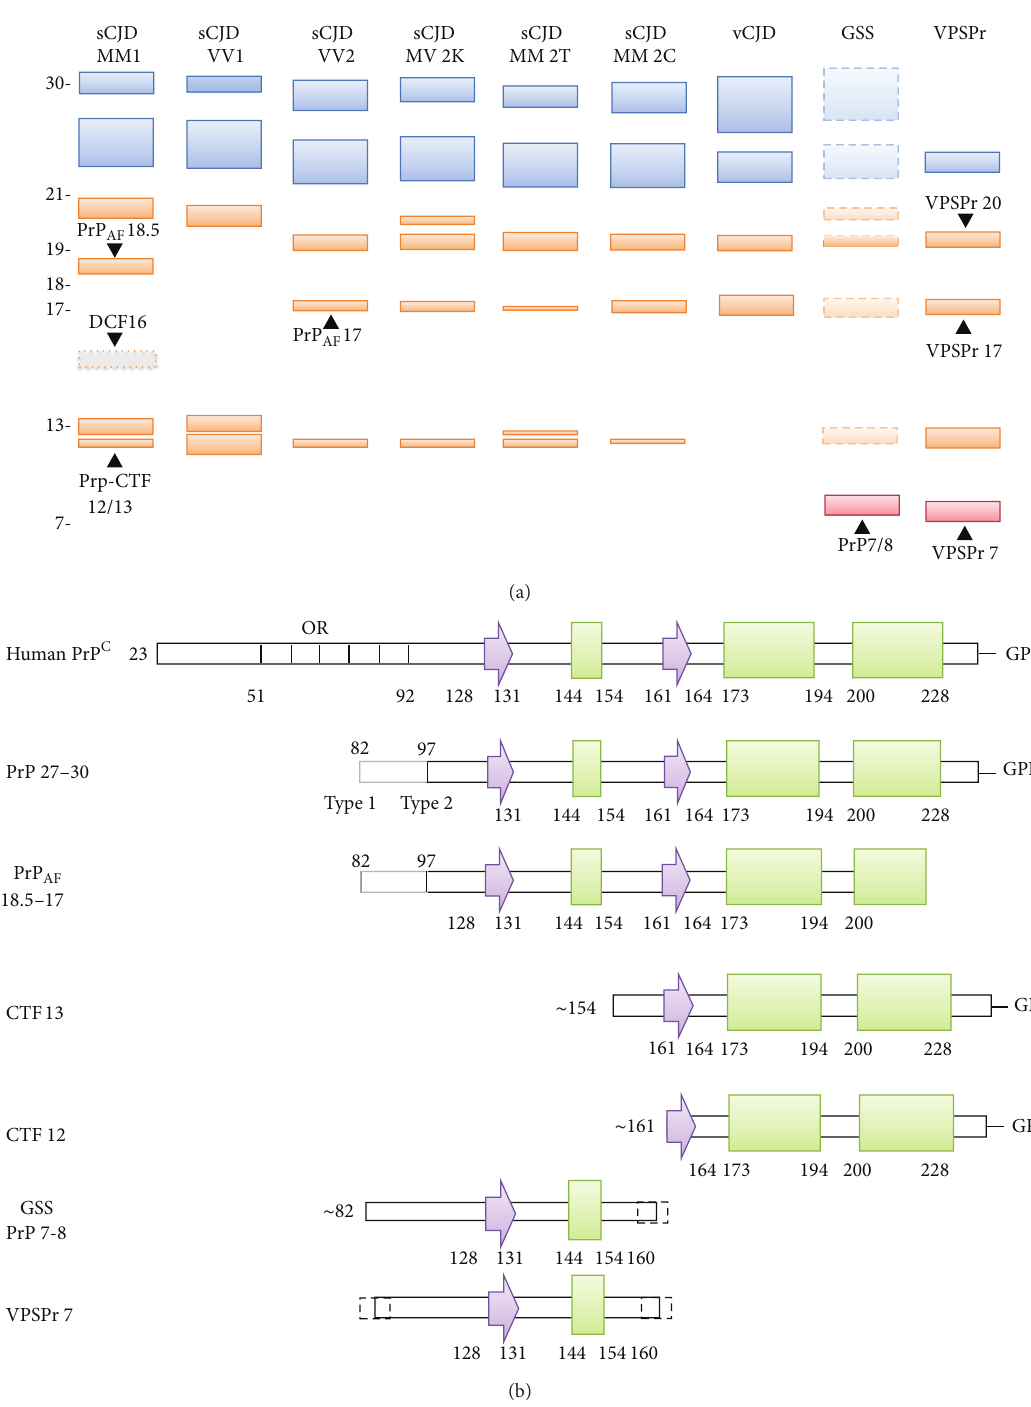
Figure1:(a)SchematicrepresentationofthespectrumofPrP res fragmentsobservedinhumanpriondiseasesandtheirelectrophoreticprofile. The unglycosylated forms of all PrP res fragments with the glycosylation sites in their sequence are indicated in orange, while the fragments lacking these sites are shown in red. Among the glycosylated peptides, only the mono- and the diglycosylated forms of PrP res 27–30 (18–21kDa range) fragments are shown (in blue). The DCF16 fragment, which is generated only in partially denaturing conditions is labeled with a dotted line and a gray color. For GSS, the fragments that have been described only associated with specific PRNP mutations (e.g., P102L or A117V) are shown with dotted lines and in transparency. Molecular weights are indicated on the left in kDa. (b) Diagrams of the secondary structural elements of human PrP C and of the PrP res fragments observed in human prion diseases. Arrows are representative of 𝛽 -strands and rectangles of 𝛼 -helices and OR indicates the octapeptide repeats region. The secondary structure numbering has been derived from pdb (Protein Data Bank) id 2LSB (human